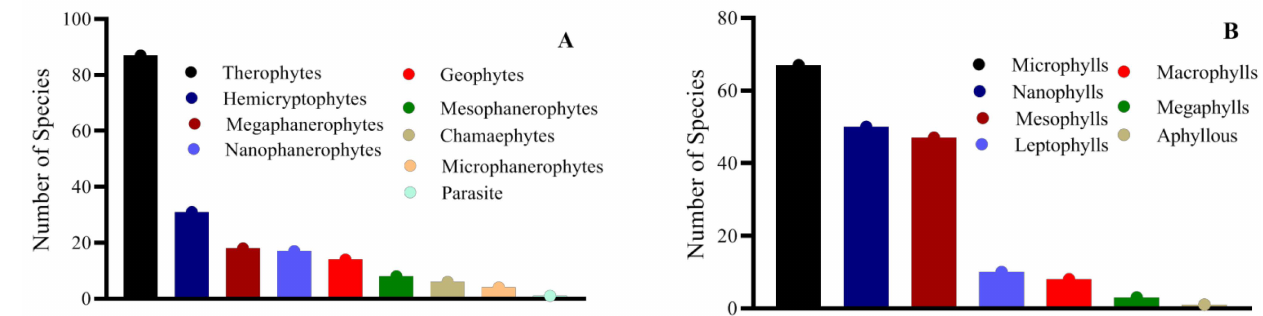
Figure 5. Raunkiaer life form ( A ) and leaf size class spectrum ( B ) of the flora recorded in the mining and non-mining sites along the River Panjkora basin.